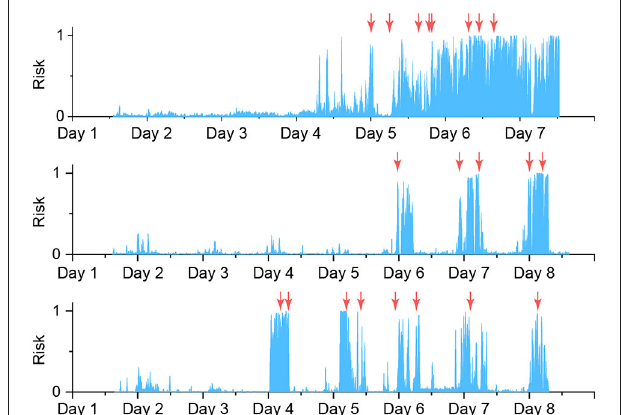
FIGURE 8 | Risk level of having seizures for top three good performance patients, from top to bottom: Pat-3, Pat-4, Pat-12. All decisions with an uncertainty level higher than 1 are discarded and not shown. Moving average of 50 steps backwards is applied to the probability score (risk level). Orange arrows indicate the seizure onsets.